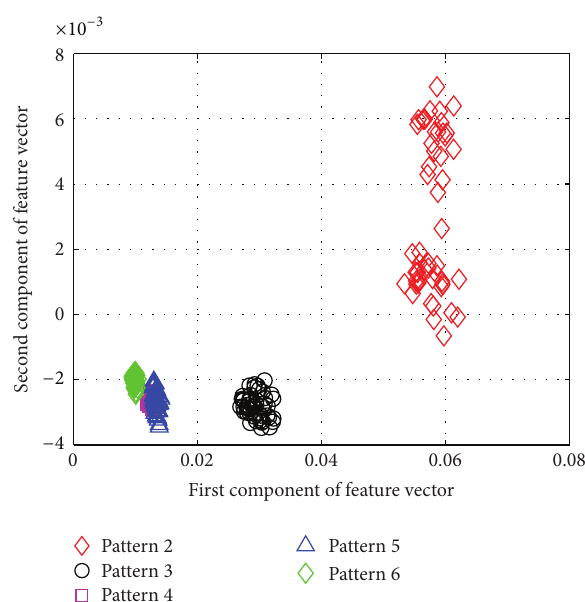
Figure20:TheDWTfeaturevectorsofdatapatternsinfirstscenario from sensor node 232.